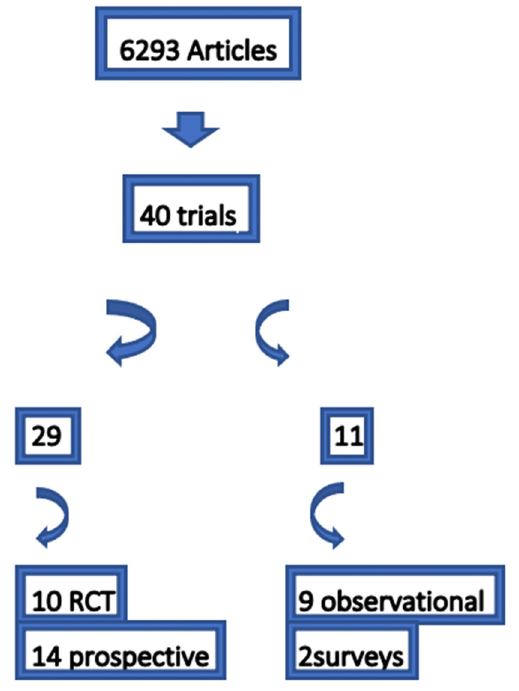
Figure 2. Included